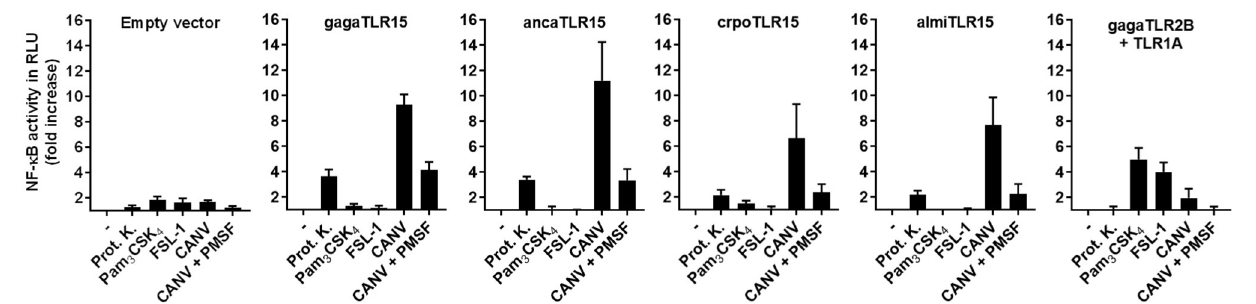
FIGURE 3 | NF- κ B activation by reptilian TLR15. HEK293 cells transiently transfected with an NF- κ B luciferase reporter plasmid and empty vector, chicken (gaga), anolis (anca), crocodile (cpro), alligator (almi) TLR15 or the gagaTLR2B and gagaTLR1A plasmids were stimulated (5h) with Proteinase K (100ng/mL), Pam 3 CSK 4 (100ng/mL), FSL-1 (100ng/mL), 10 µ L of Chrysosporium anamorph of Nannizziopsis vriesii (CANV) sterile culture supernatant or 10 µ L of CANV supernatant pre-treated (30min) with 1mM PMSF. Values are the mean ± SEM fold increase of NF- κ B activity, represented by luciferase activity in Relative Light Units (RLU),